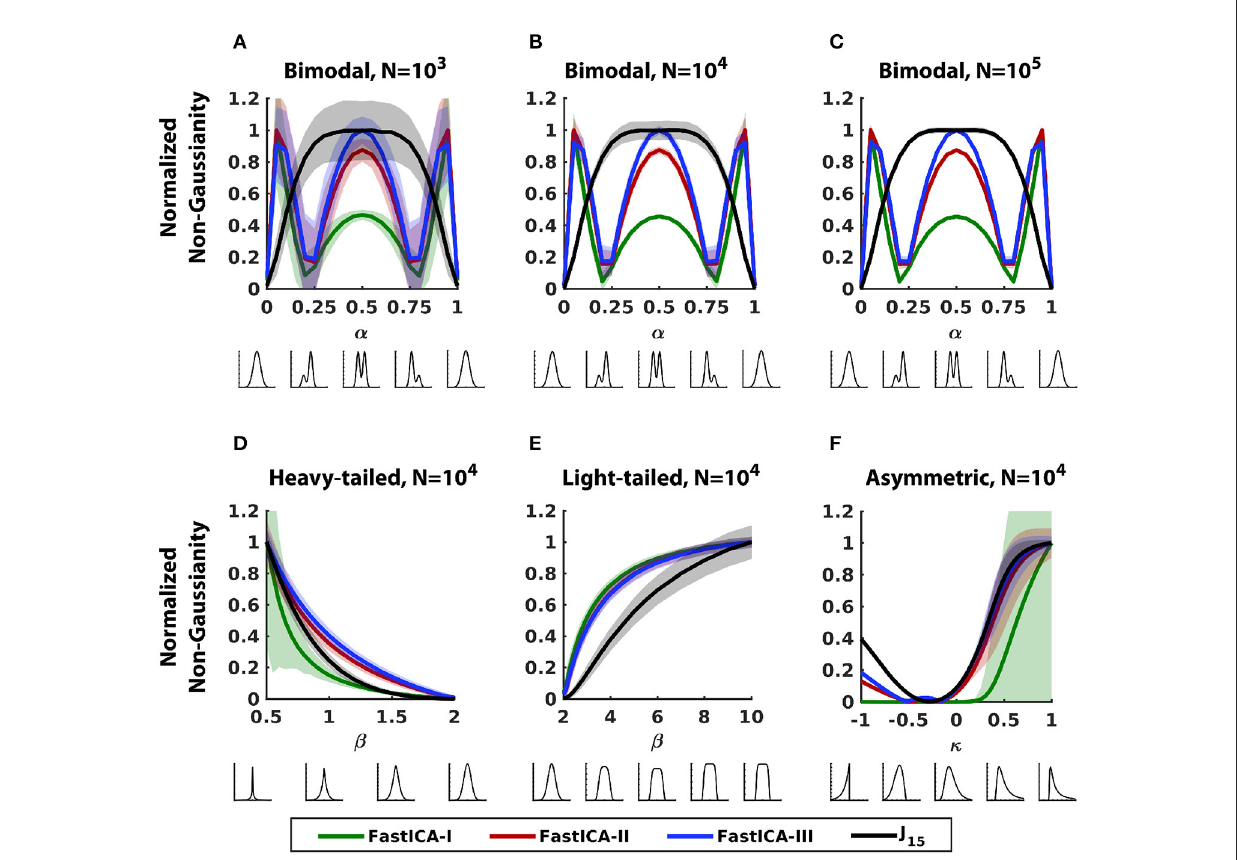
FIGURE2 Comparison of the sensitivity of J 15 to that of FastICA contrast functions for 1D datasets. (A–C) Bimodal distributions (Section 2.3.1) with a range of sample sizes. (D) Heavy-tailed distributions (Section 2.3.2). (E) Light-tailed distributions (Section 2.3.2). (F) Asymmetric distributions (Section 2.3.3). Other conventions as in Figure